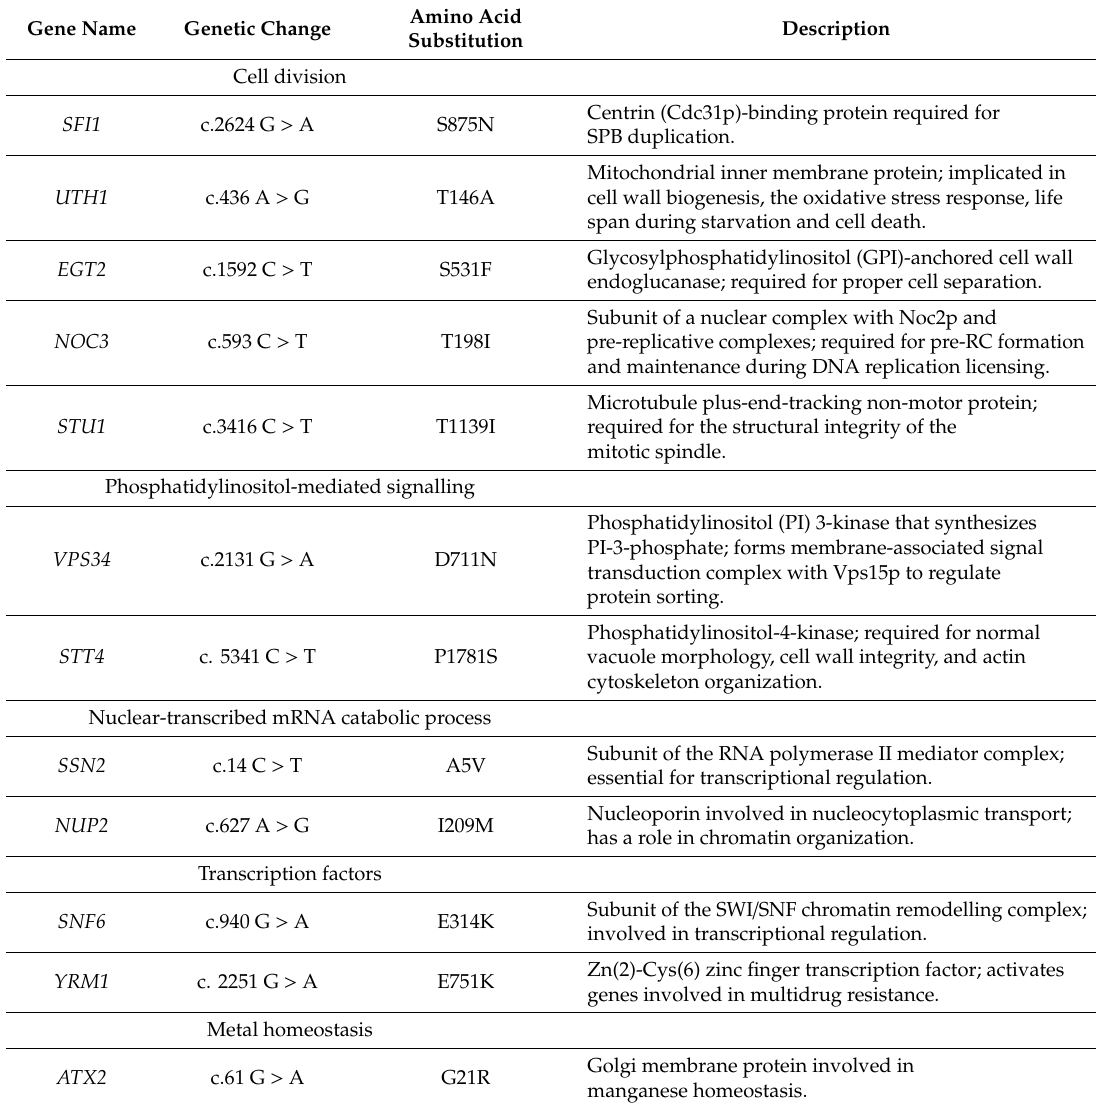
Table 5. Selected mutations in M8FE compared to 905